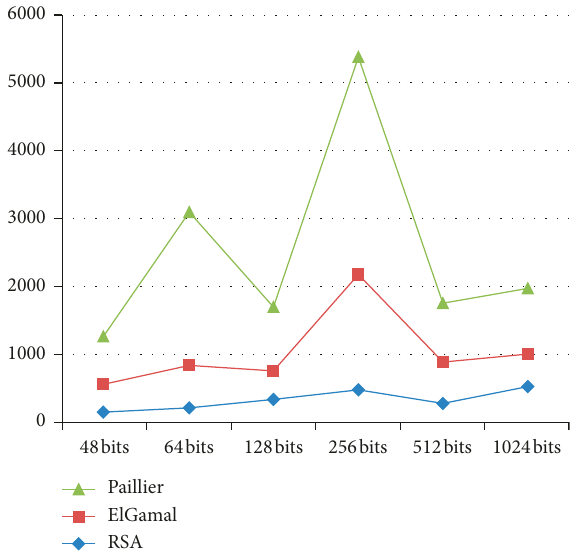
Figure 8: Time consumption during the encryption process.